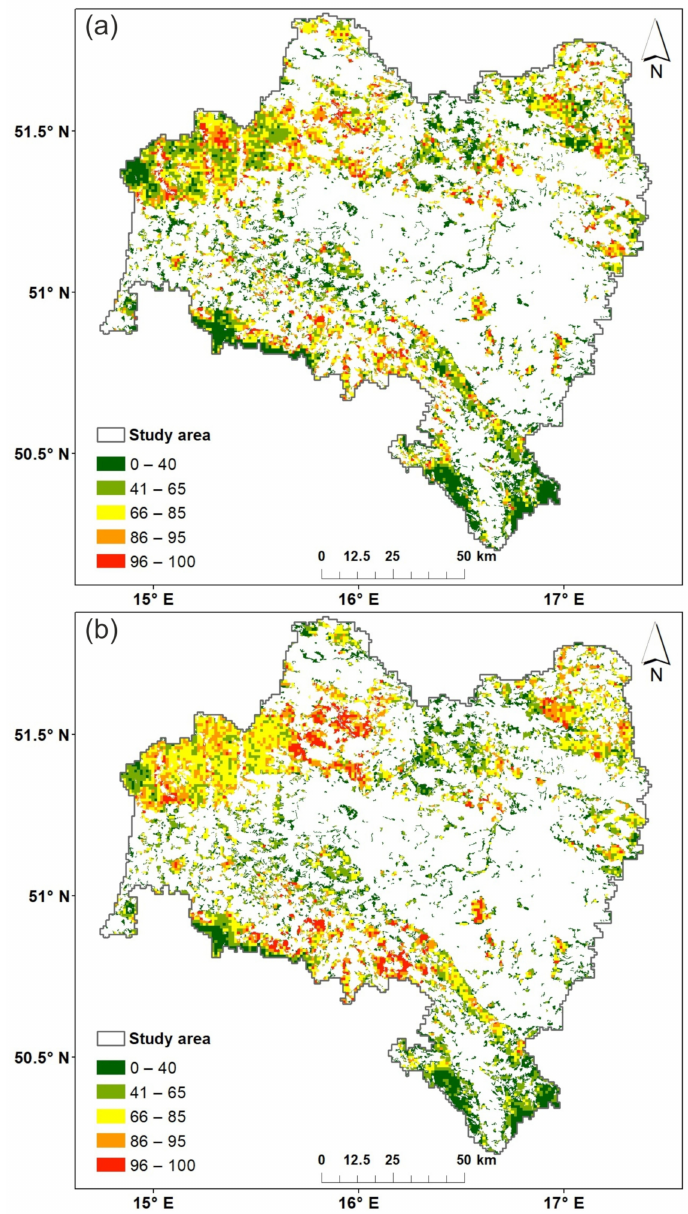
Figure 5. Maps of forest fire probability based on percentages with the ( a ) GBM model and ( b ) RF